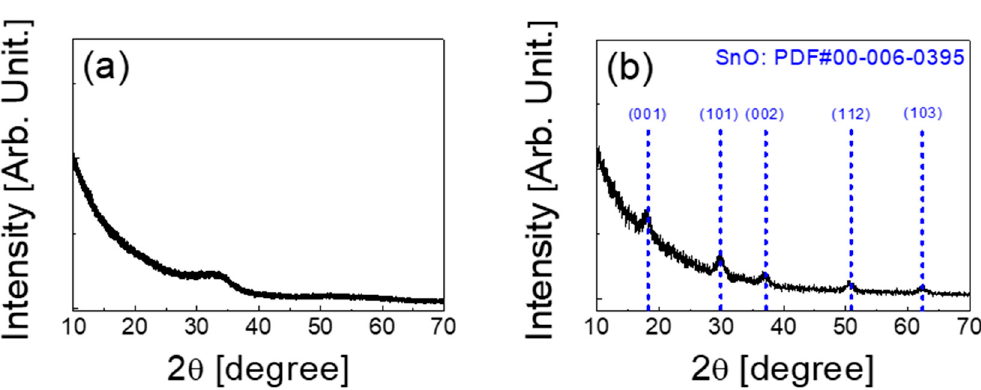
Figure 2. XRD patterns of the ( a ) IGZO and ( b ) SnO thin films used as channel layers in this work.